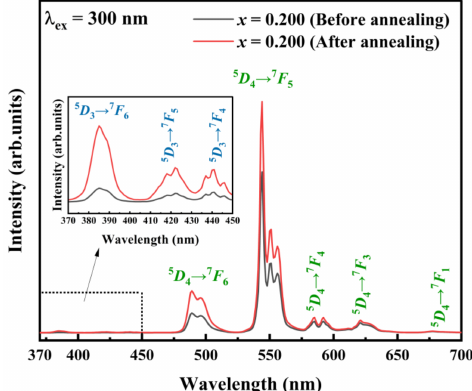
Figure 13. Emission spectrum of (ZrO 2 ) 92 (Y 2 O 3 ) 7.800 (Tb 4 O 7 ) 0.200 crystals before and after annealing at 1500 ◦ C in a H 2 /Ar atmosphere.